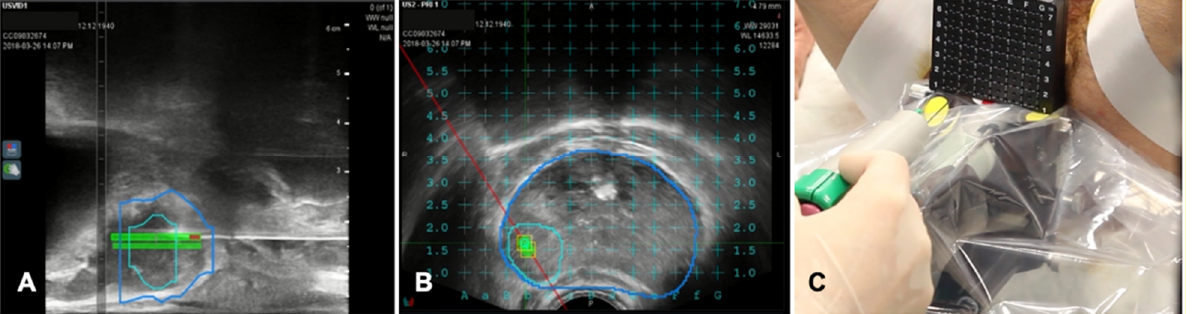
Figure 6. Case of biopsies of a magnetic resonance imaging (MRI) visible prostate nodule. ( A ) Parasagittal long axis view of intraprocedural ultrasound fused with regions of interest from MRI. Target lesion has been segmented in MRI images and is encompassed by the green line in the prostate volume (blue line). ( B ) Axial view of the target lesion (green line) in prostate parenchyma (blue line) derived from MRI. A reference grid is superimposed to select the appropriate space for needle placement. ( C ) A transperineal biopsy needle is then placed in the selected hole in the reference grid and advanced into the target lesion.